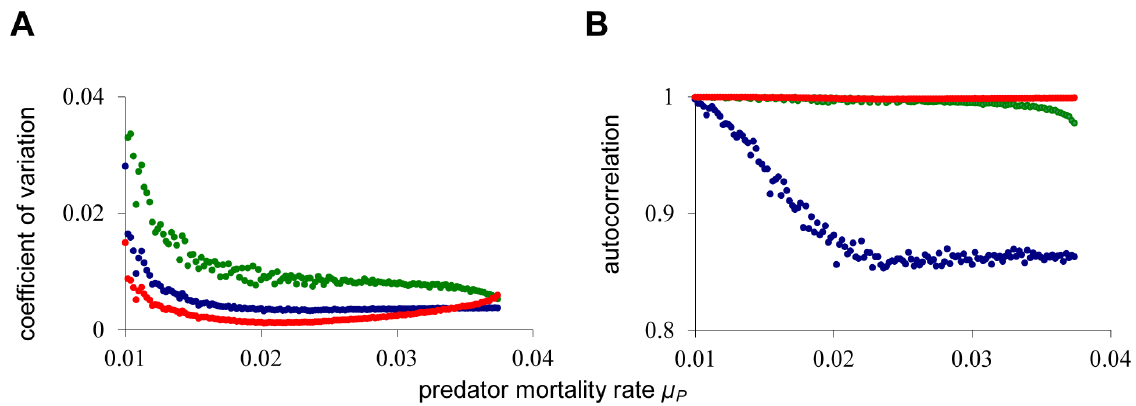
Figure 7. Early warning signals in the fully size-structured population model of de Roos and Persson [ 17 ] . Independent white noise with s =0.002 is added to the death rates of all juvenile consumers. Bifurcation procedure and colors are identical to Figure 2, with predator mortality staring at m P =0.01 (note that the original article uses parameter d instead of m P ), and incremented with D m P =0.0002 after each 50,000 time units. The fold catastrophe in this model is located at approximately m P =0.038. Coefficient of variation and lag-1 autocorrelation are computed for each value of m P over the last 40,000 time steps. ( A ) Coefficient of variation, and ( B ) Autocorrelation. All other parameters have default values as used by de Roos and Persson [17].